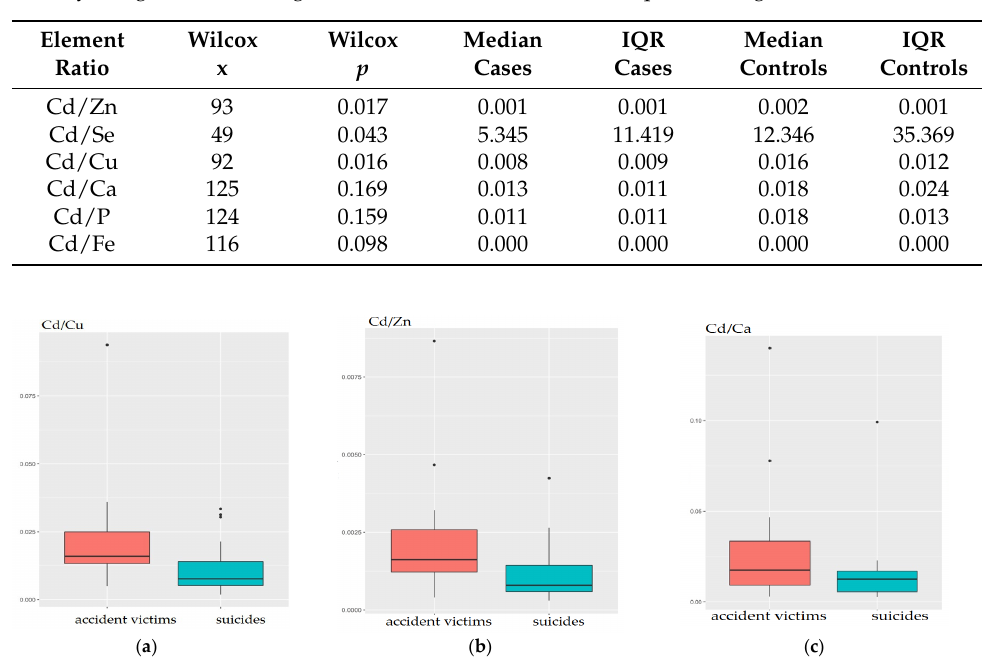
Table 3. Differences between controls and cases considering selected elemental ratios. The analysis was performed by the Wilcoxon Mann-Whitney rank sum test (x-value of the test, p-value, Ansari- Bradley test gives all values greater than 0.05); IQR means interquartile range.